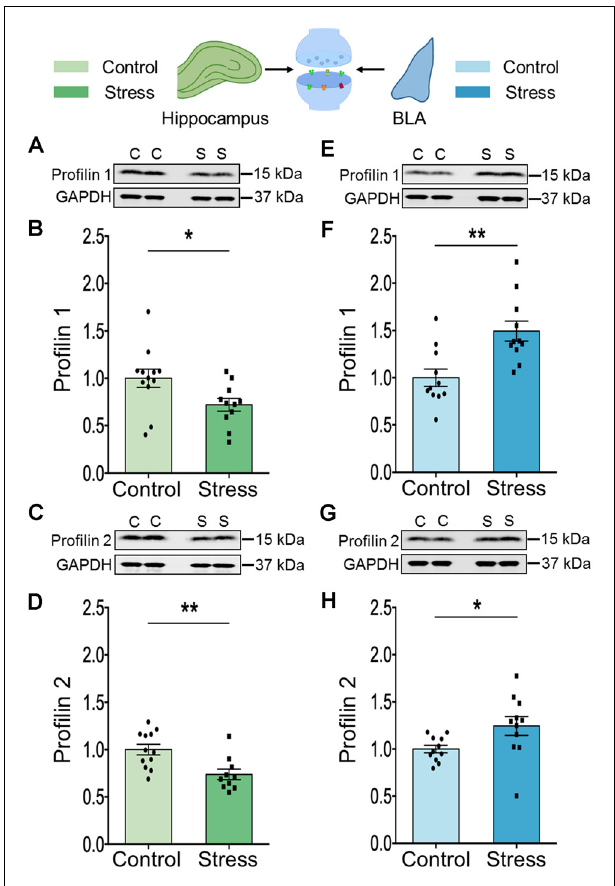
FIGURE 4 | Chronic stress leads to contrasting effect on the expression profile of profilin isoforms in the hippocampus and amygdala. (A–D) A significant decrease in the expression of both the profilin isoforms, profilin 1 and profilin 2 has been observed in the synaptoneurosome fraction of the hippocampus of the stressed rats compared to controls as shown in the representative western blots (A,C) and the summary graphs (B,D) respectively. (E–H) A significant increase in the expression of both the profilin isoforms, profilin 1, and profilin 2 has been observed in the synaptoneurosome fraction of the amygdala of the stressed rats compared to its control counterparts as shown in the representative western blots (E,G) , and the summary graphs (F) and (H) respectively. In the figure, C stands for control and S stands for stress. Data are represented as means ± SEM; data normalized to control animals; N = 10–12 rats/group; * p < 0.05, ** p < 0.01. Out of 11 data points in (F) , five data points have used the same internal control for analysis as in Figures 2G , 3G since they are from the same